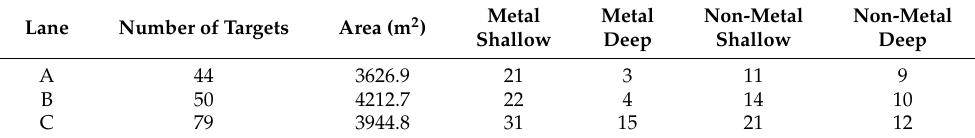
Table 2. Data collection summary for each